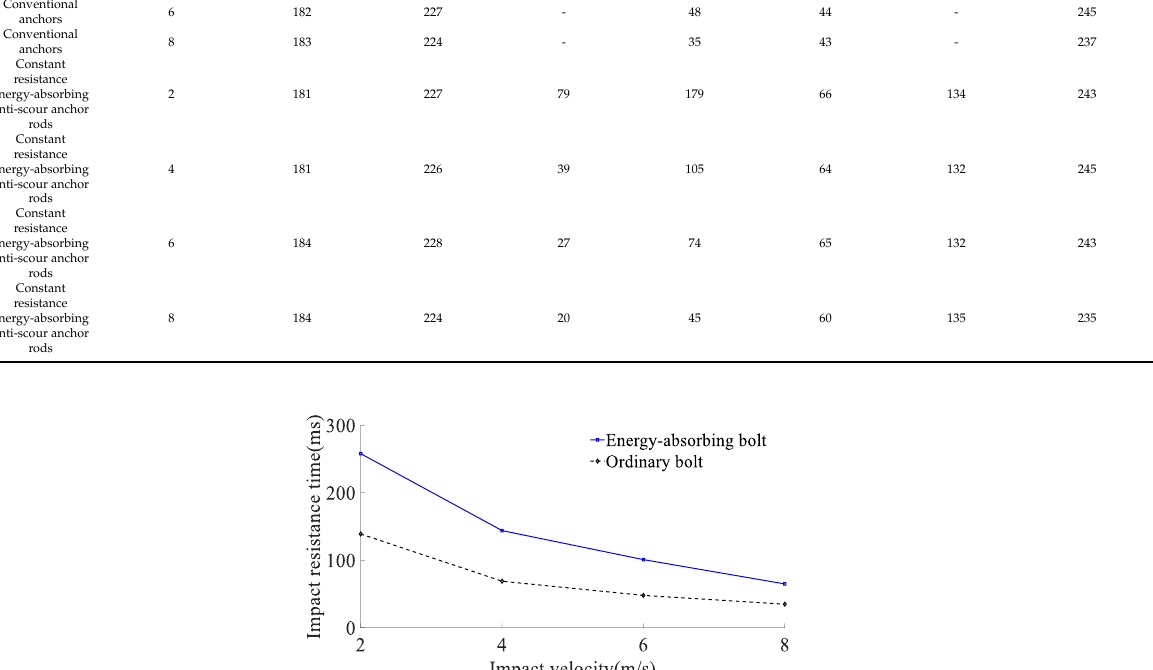
Figure 13. Anchor impact resistance time at different impact velocities.